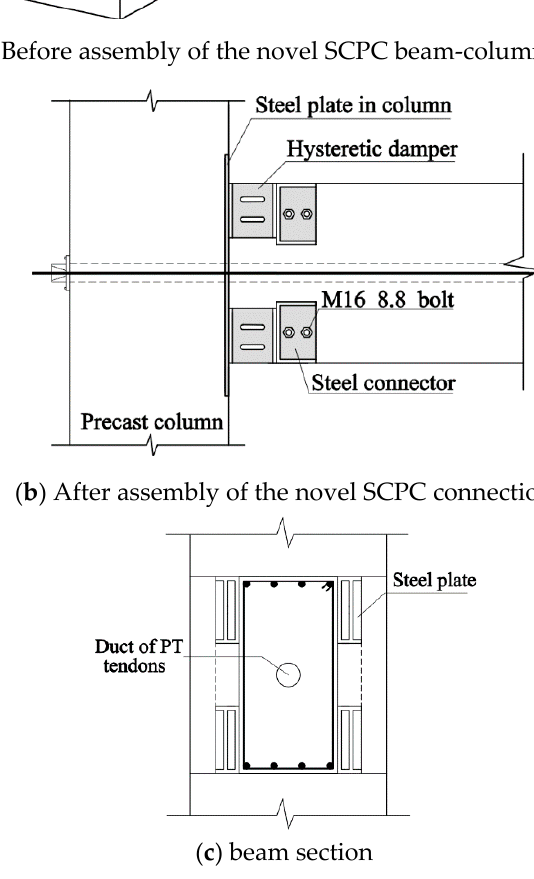
Figure 1. Details of construction of the novel self-centering precast concrete (SCPC) connection.